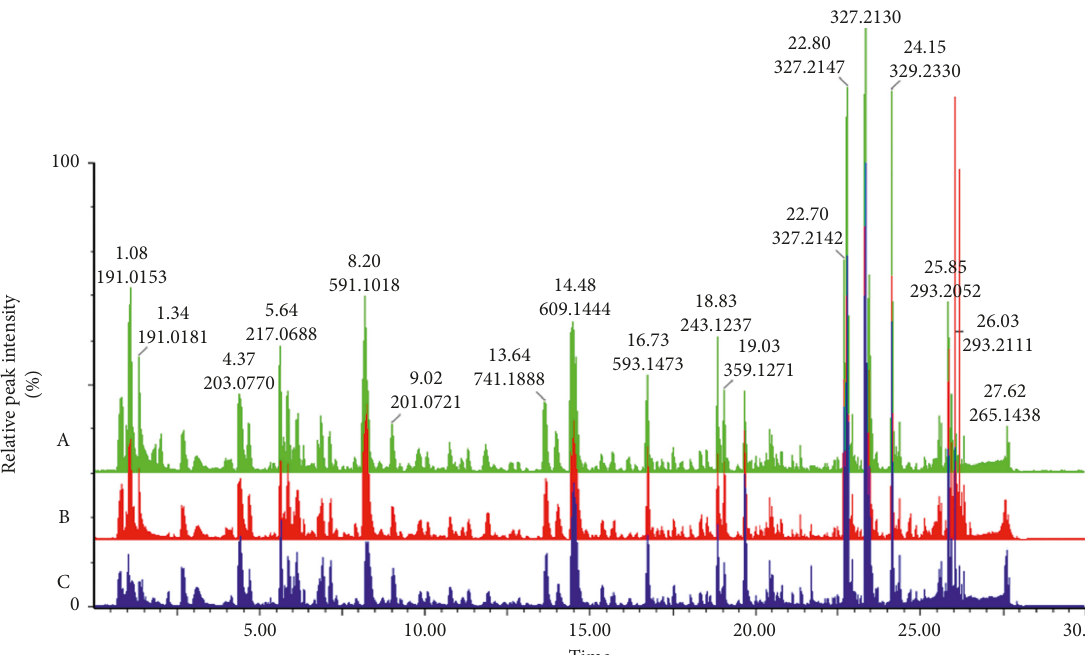
Figure 1: UHPLC-qTOF-MS chromatogram of 40% (a), 60% (b), and 80% (c) aqueous methanol Solanum retroflexum leaf extracts showing peaks detected in the negative- and positive-ionization